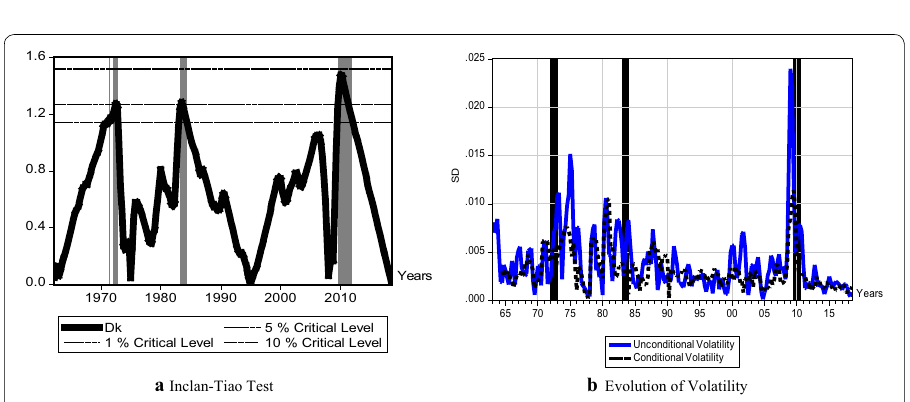
Fig. 2 Break dates and evolution of volatility